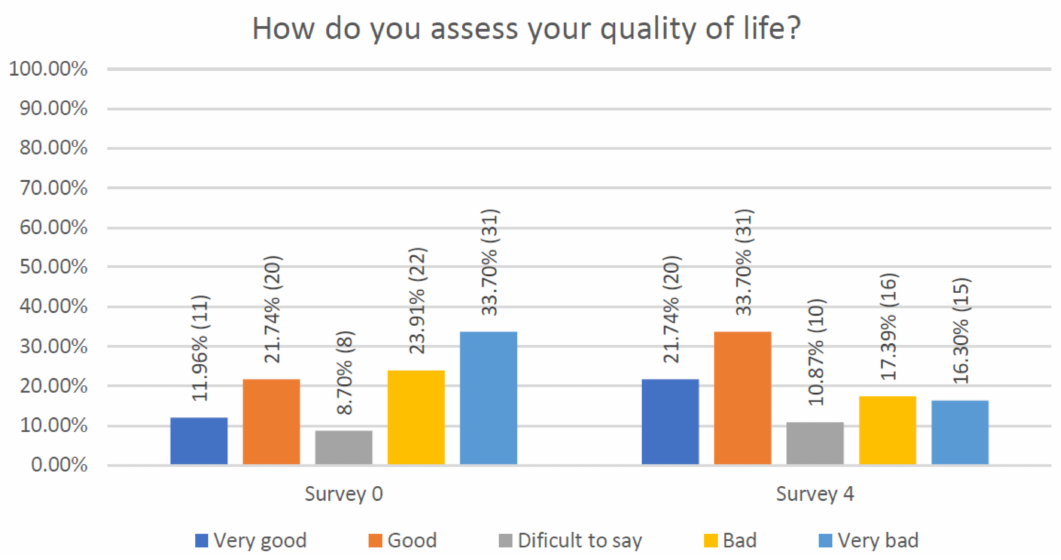
Figure 10. Quality of respondents’ life including the assessment of pain and mood. When assessing the level of patient satisfaction after coordinating the educational program, patients mostly evaluated and accepted it very well (Figure 11). Only 1.09% of the respondents declared a bad